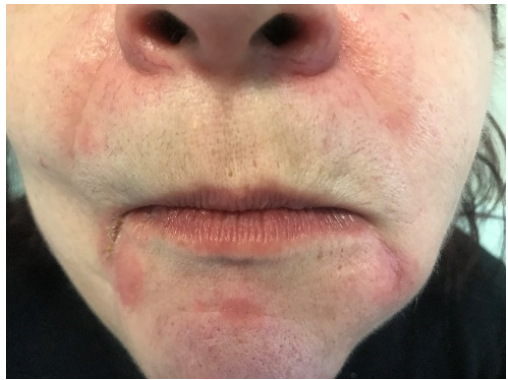
Figure 4. Perioral dermatitis.